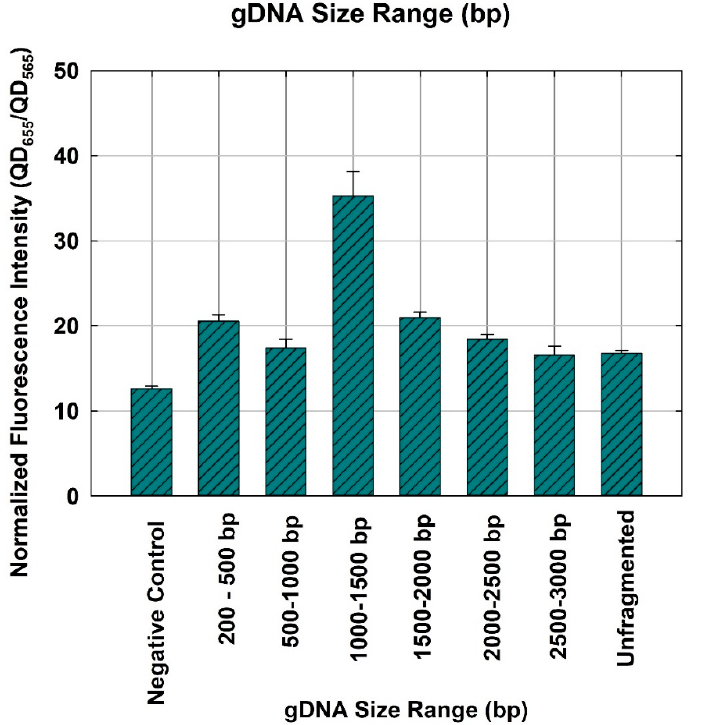
Figure 3. Gene quantification for P. putida detection, depicted by the normalized fluorescence intensity (QD 656 /QD 565 ) of the NanoGene assay using gDNA of different size ranges. The bars and errors represent the mean and standard deviation of triplicate samples.